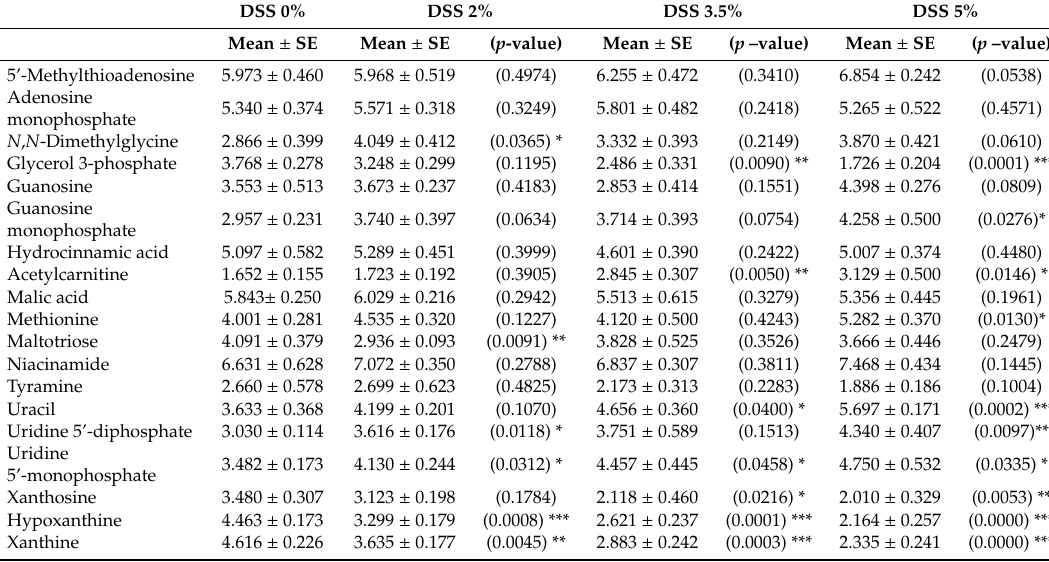
Table 3. The relative concentrations of marker metabolites, acquired by MS spectroscopy of DSS 0%, DSS 2%, DSS 3.5%, and DSS 5%